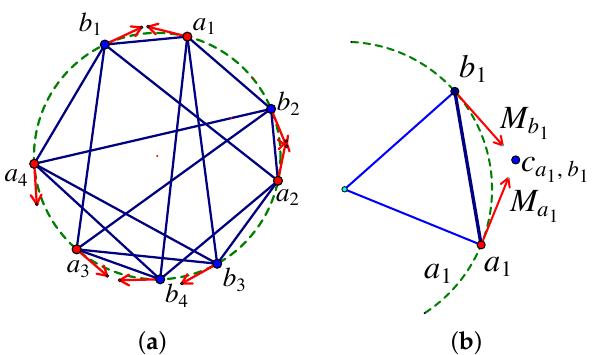
Figure 23. With a bipartite framework on a circle, the projective momenta are all tangent to the circle ( a ). These momenta lines meet in the center of motion of a bar—appearing as a weighted point which is a multiple of the polar of the edge in the conic ( b